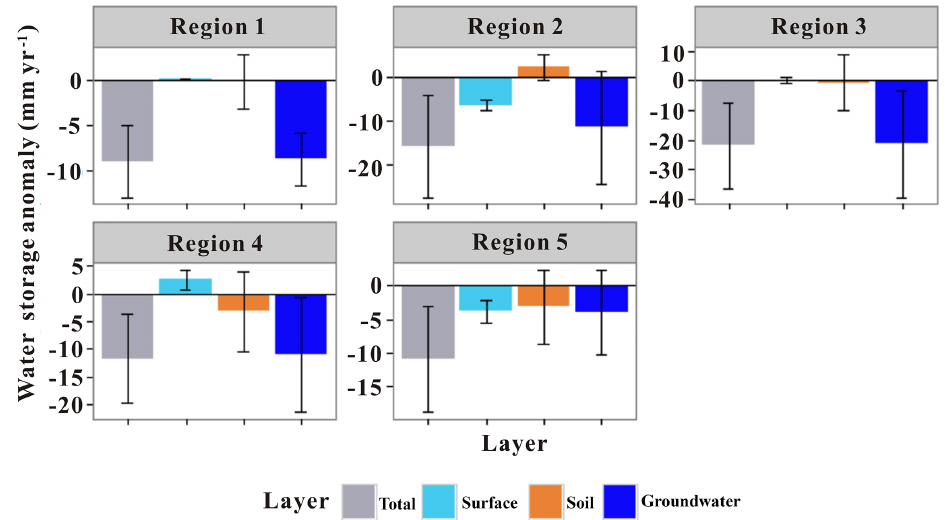
Figure 5. Contributions of different hydrological storages to TWS changes in five hotspots. Uncertainties represent 95% confidence